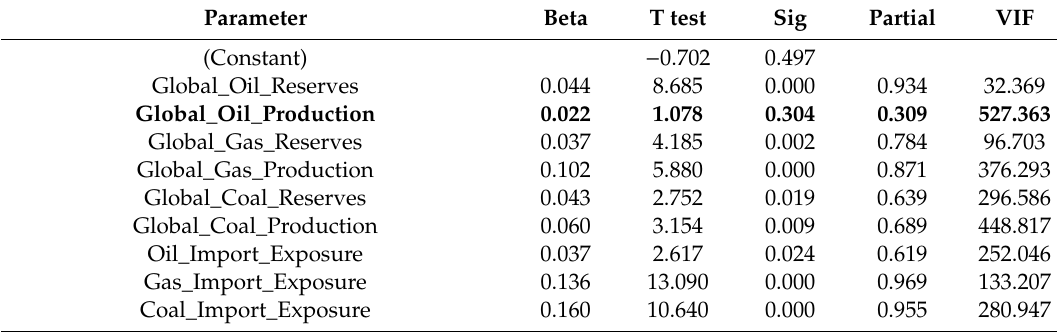
Table 1. Multicollinearity and partial correlation without influence on